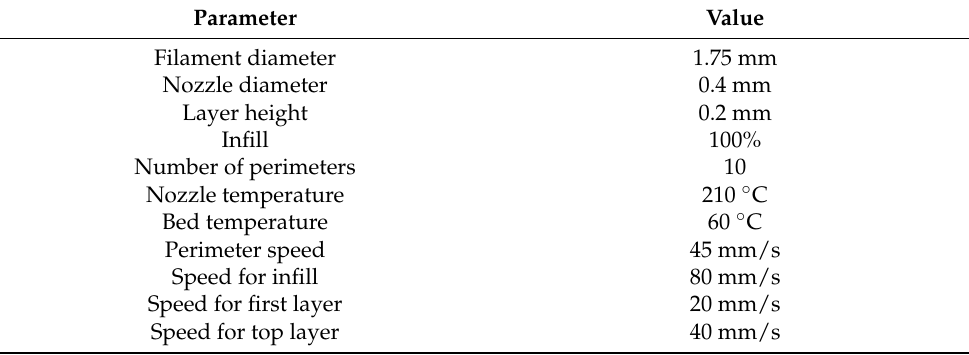
Table 2. Basic parameters of printer